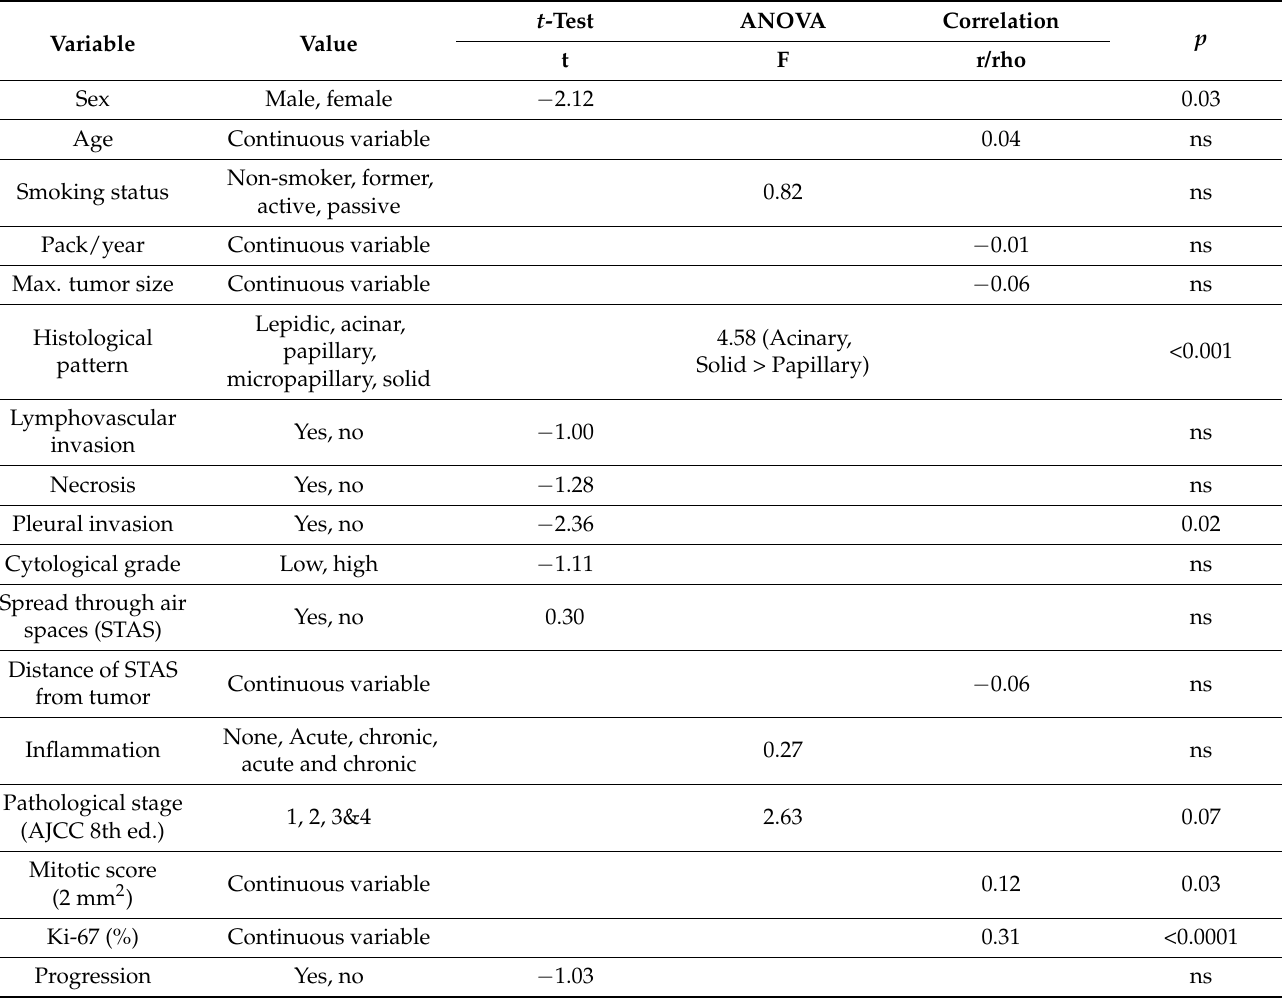
Table 2. Associations between ZNF768 H -score and clinicopathological features in LUAD using univariate